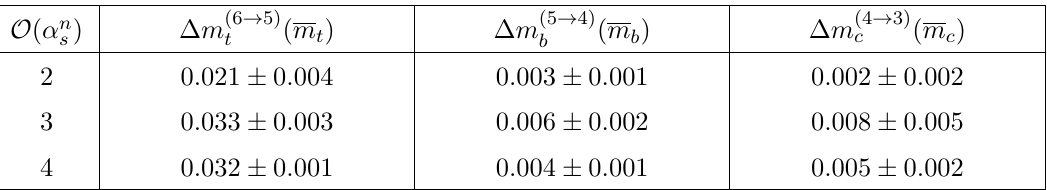
Table 3 . The MSR-MS mass matching corrections for the top, bottom and charm quarks